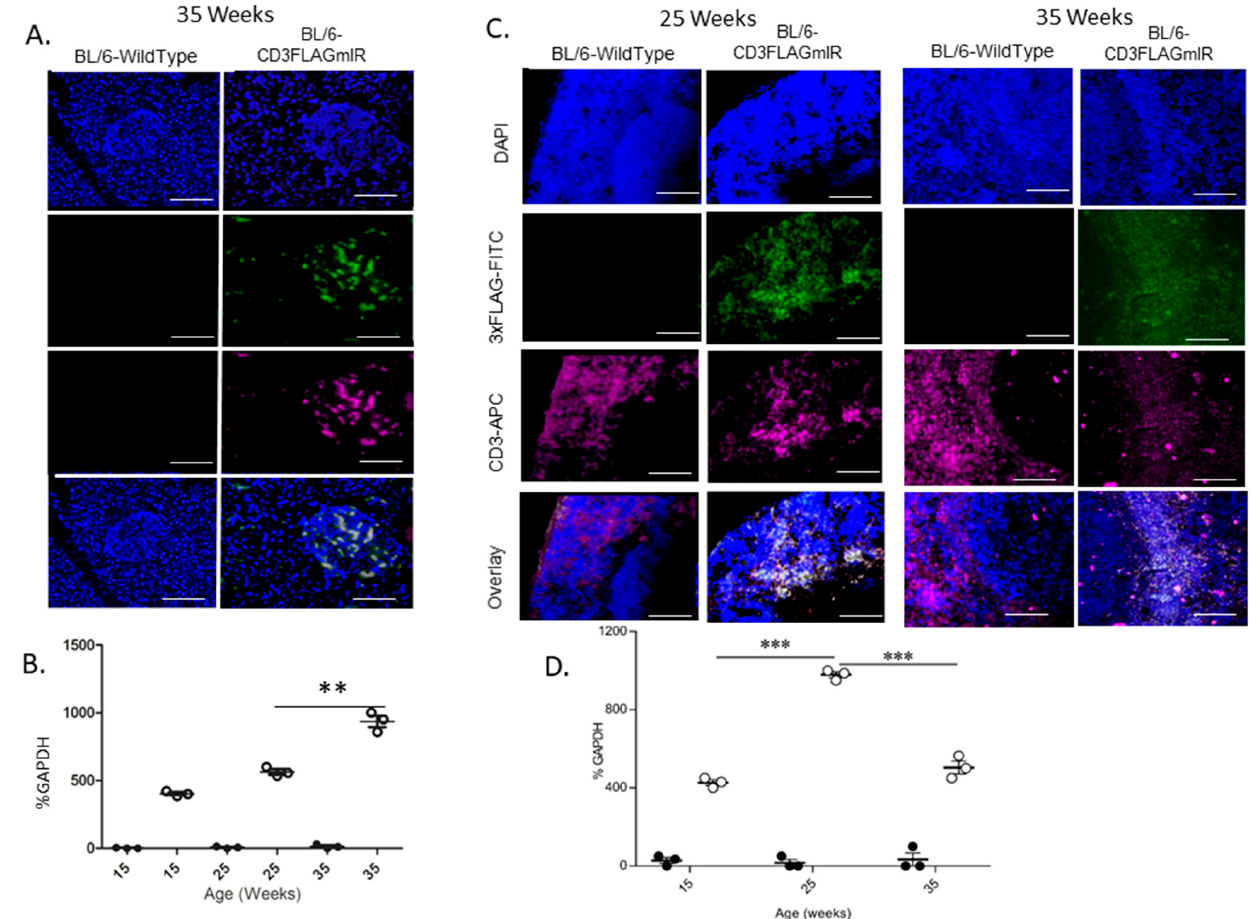
Figure 1. Phenotypic study of FLAG mouse Insulin Receptor (mIR) expression on pancreatic and splenic tissue of BL/6 and BL/6-CD3FLAGmIR male mice. Immunofluorescence (IF) staining for CD3 + T cells and FLAGmIR transgene expression. Pancreatic at 35 weeks of age ( A ) and splenic at 25 and 35 weeks of age ( C ) paraffin tissue sections were stained using anti-FLAG FITC labeled antibody (green), anti-CD3 APC labeled antibody (magenta), and DAPI-UV stain for nuclei (blue) and imaged at 20x. Scale bar: 300 µM. qPCR analysis of transgene 3xFLAGmIR in pancreatic ( B ) and splenic ( D ) tissue at 15, 25, and 35 weeks of age in BL/6 (black circles) and BL/6-CD3FLAGmIR transgenic (white circles) male mice. ( n = 3 mice per group). One Way ANOVA * p < 0.05, ** p < 0.01, *** p < 0.001.